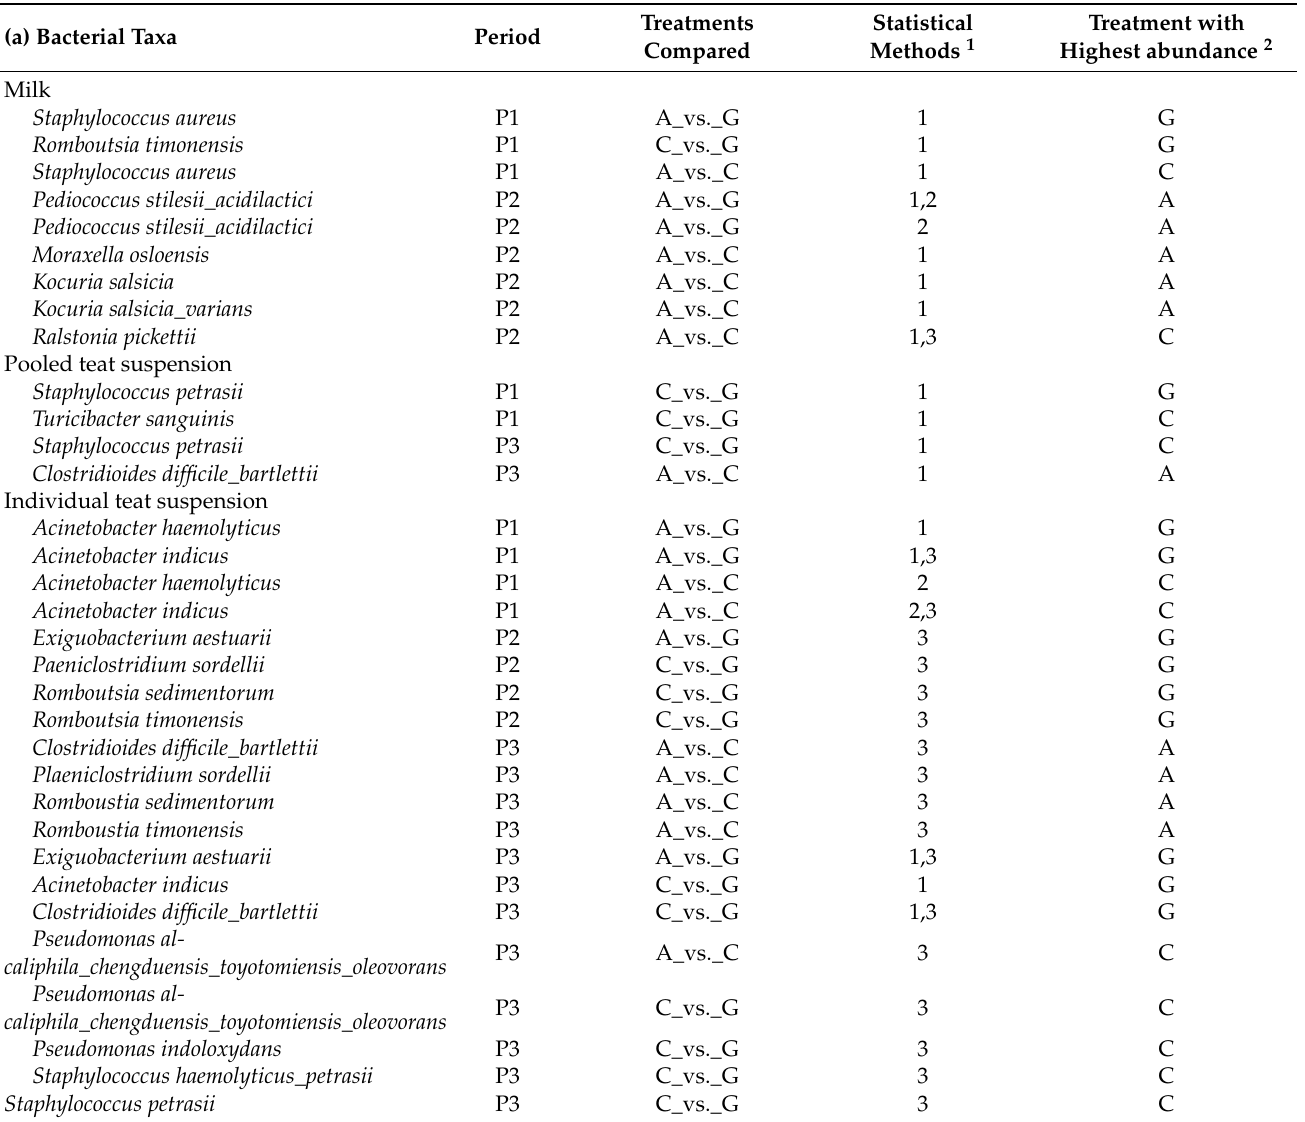
Table 6. Differential analysis of bacterial (a) and fungal (b) ASVs present at more than 1% of abundance in milks and in the pooled and individual teat suspensions according to the